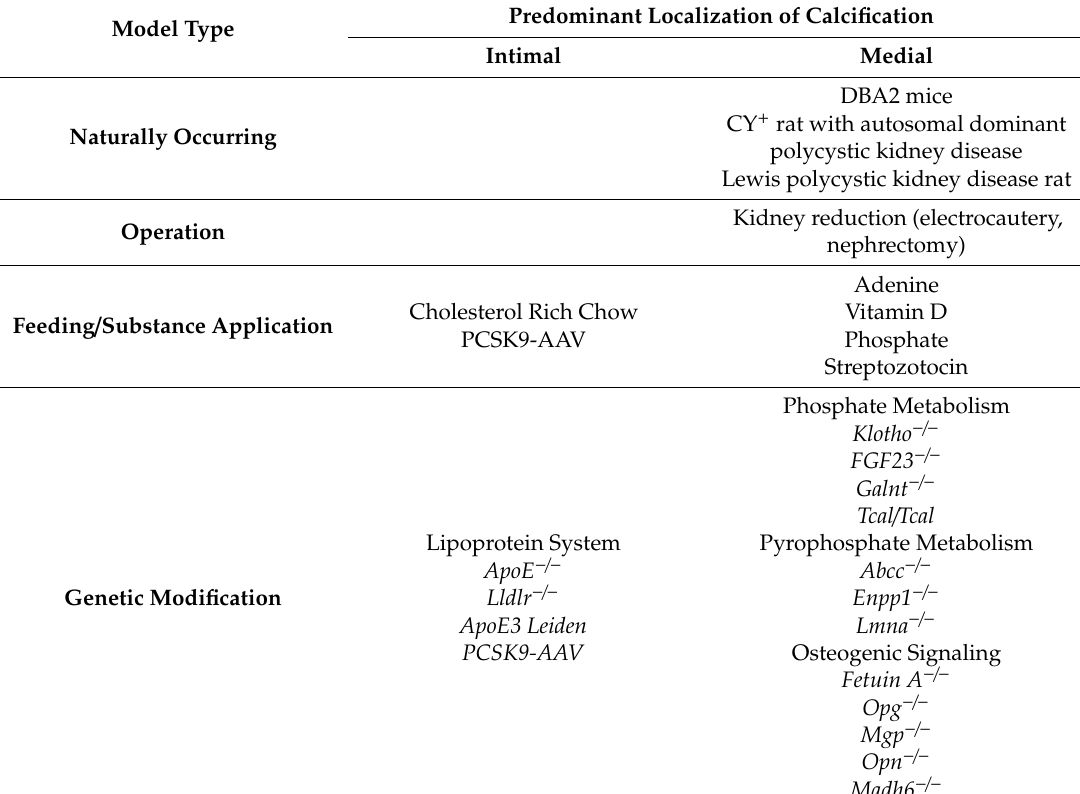
Table 3. In vivo research models inducing vascular calcification in mice and